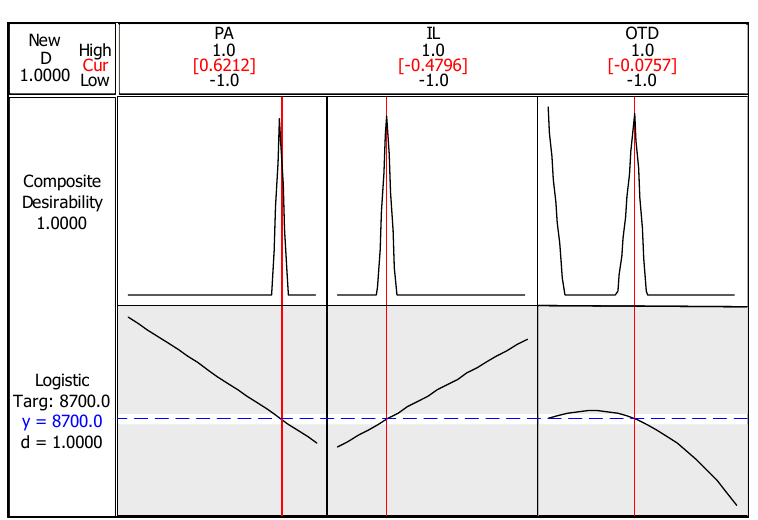
Figure 9. Logistics Cost Optimization Chart. 5.